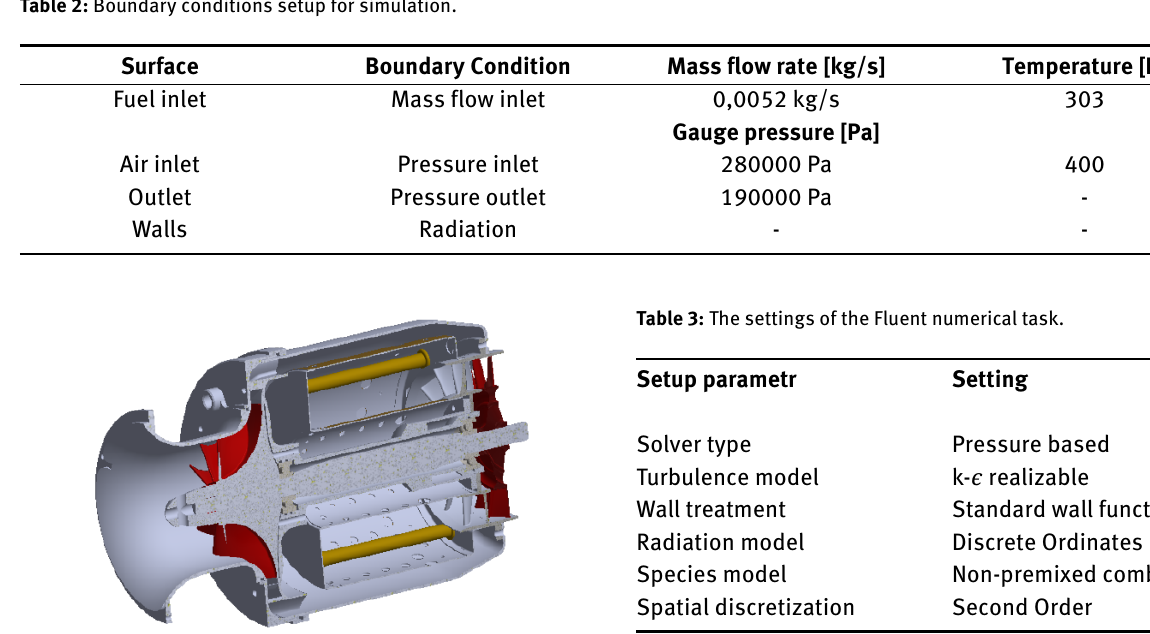
Table 2: Boundary conditions setup for simulation.